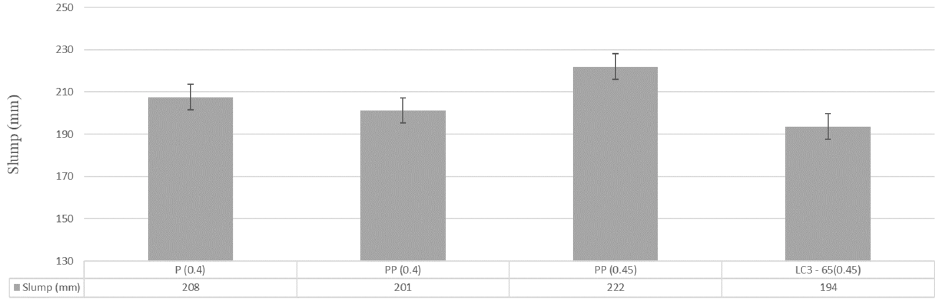
Figure 5. Effect of calcined clay addition on Slump.